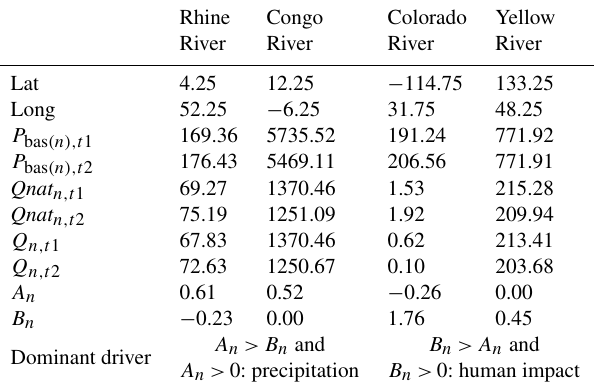
Table 1. Examples of indicator calculation (Sect. 2.4.2) for four large river basins at grid cells located near the outflow to the ocean for the forcing GSWP3 and changes from 1941–1970 ( t 1) to 1971– 2000 ( t 2). Values for latitude and longitude in decimal degrees, values for A n and B n are dimensionless, other numbers are in km 3 yr − 1 . Explanations of variables other than lat and long, see Sect.